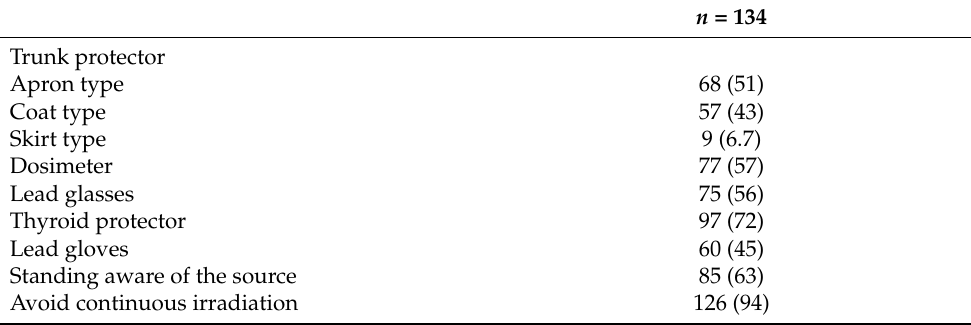
Table 3. Actual status of radiation protection of participants who were in the action